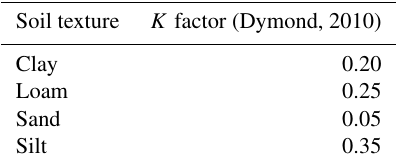
Table 4. K -factor values from Dymond (2010) for soil textures in New Zealand.